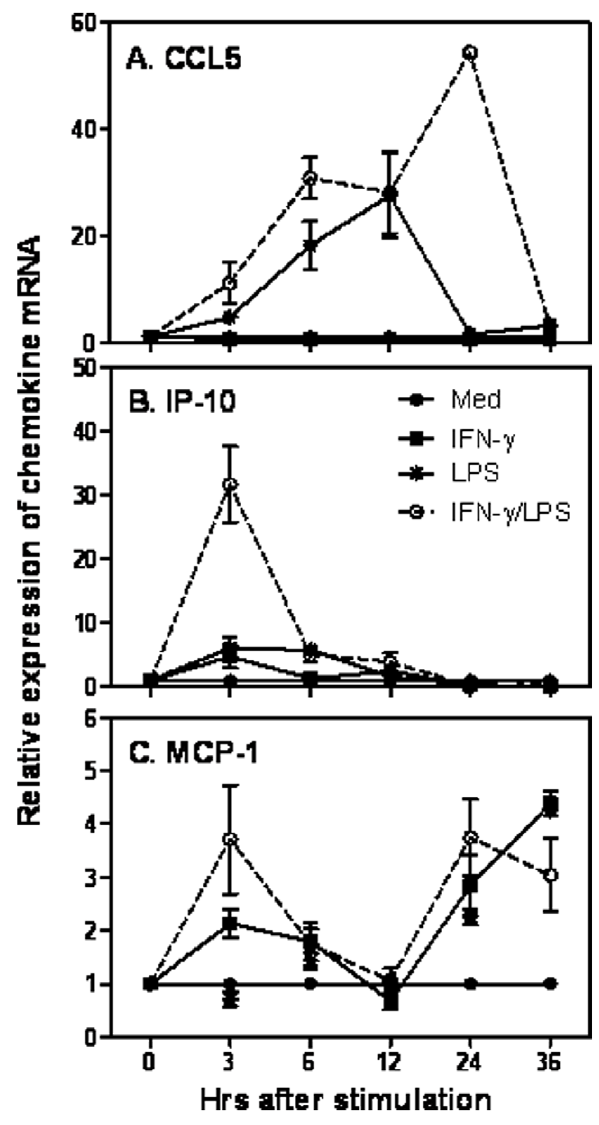
Figure 2. Kinetic expression of chemokines in rat vascular smooth muscle cells. Total RNA was extracted from rat smooth vascular muscle cells treated with IFN- c , LPS, or IFN- c plus LPS for different times as indicated and reverse transcribed into cDNA for measurement of CCL5 (A), IP-10 (B) and MCP-1 (C) expression by qRT- PCR. Data were normalized relative to GAPDH mRNA expression levels in each respective sample and further normalized to the results from the un-treated group, which was set as 1.